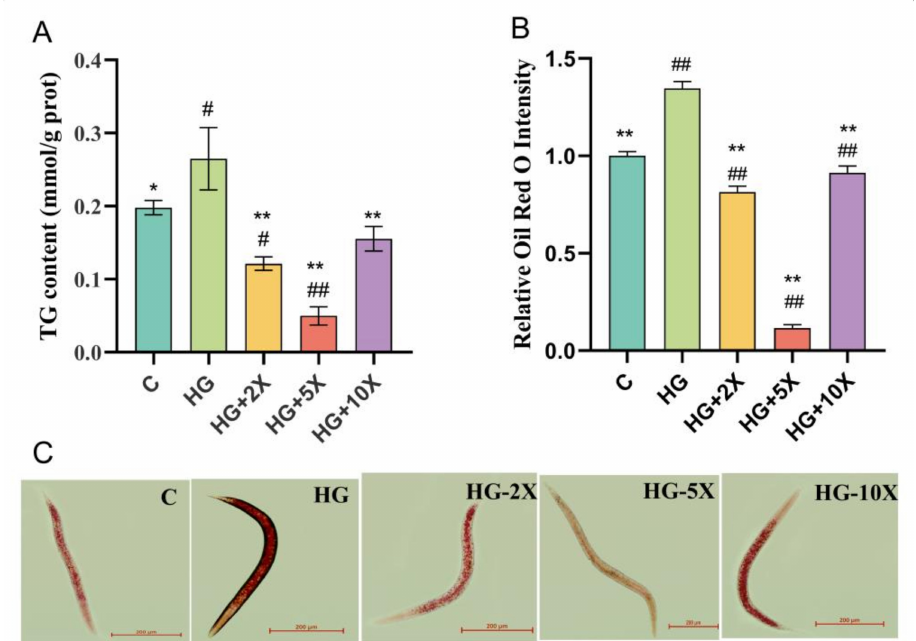
Figure 3. Effect of supplementation with A. muciniphila cell-free supernatant on lipid metabolism in C. elegans. ( A ) TG content; ( B ) Quantification of data shown in ( C ). N = 10. ( C ) Oil Red O staining nematode fat and selected intuitive characteristics map. Bar, 200 µ m. Results are expressed as mean ± SD deviation, and p -values are calculated by Tukey’s test. Compared with the control group, # and ## are significantly different at p < 0.05 and p < 0.01, respectively; compared with the high-glucose group, * and ** are significantly different at p < 0.05 and p < 0.01,